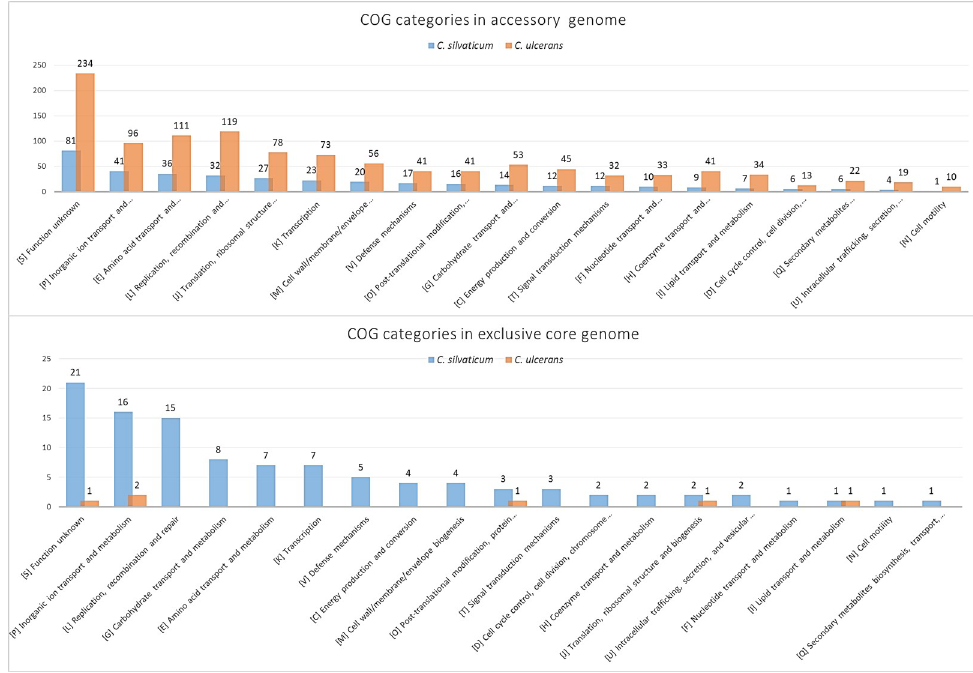
Fig 7. Clusters of orthologous groups (COGs) in the accessory and exclusive core genomes of Corynebacterium silvaticum and C . ulcerans annotated using eggNOG-mapper v2. COG categories are sorted from most abundant to less abundant in C . silvaticum . In C . silvaticum , 356 out of 793 proteins from the accessory genome and 93 out of 174 proteins of the exclusive core genome had a COG category. In C . ulcerans , 1,065 out of 2,064 proteins from the accessory genome and six out of nine proteins of the exclusive core genome had a COG category.